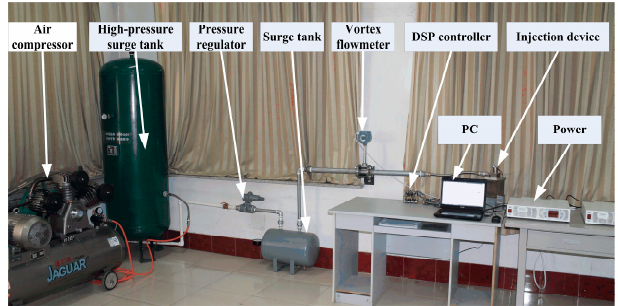
Figure 4. Flow measurement bench of the injector.